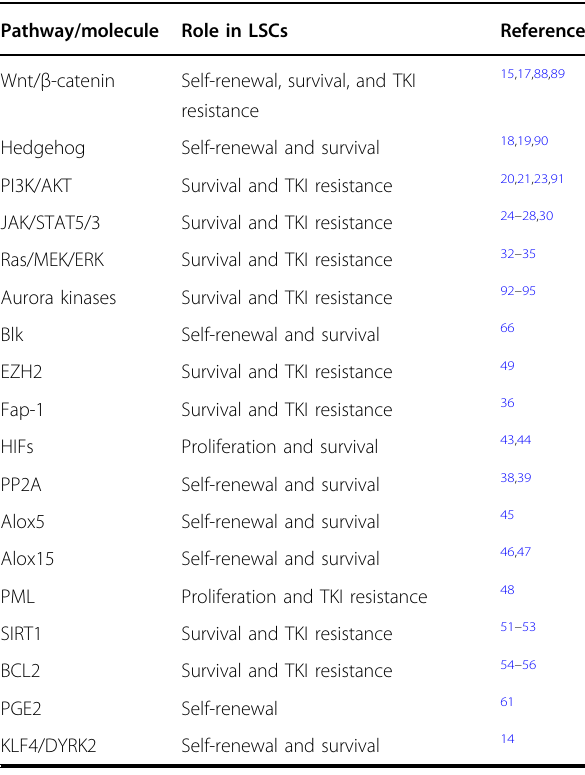
Table 1 Signaling pathways/molecules involved in the maintenance of CML